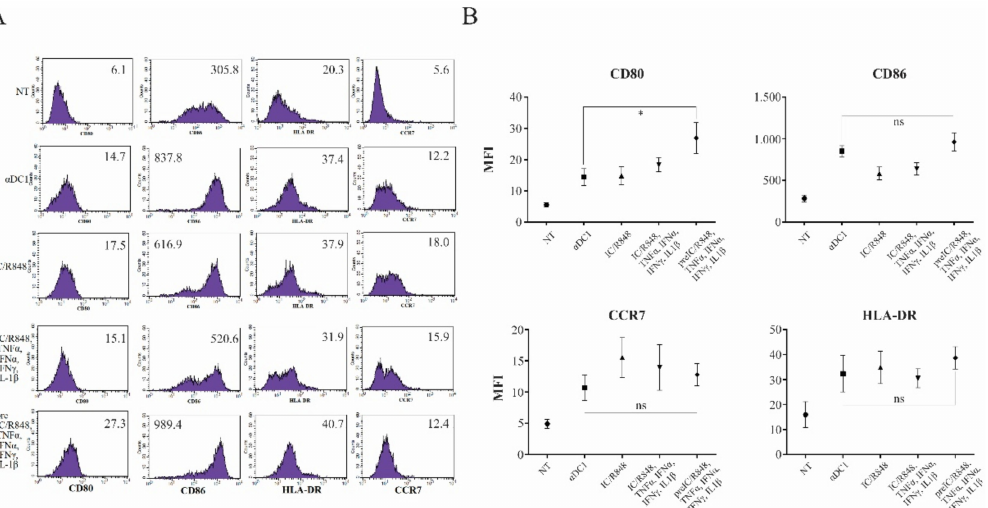
Figure 2. zDCs display optimally matured phenotype. ( A , B ) Dendritic cells were differentiated from monocytes isolated from freshly prepared human buffy coats, as described in the Materials and Methods. They were then either left untreated (NT, immature DCs) or stimulated for 24 h using different maturation protocols, focusing on various combinations of TLR3 and TLR8 agonists